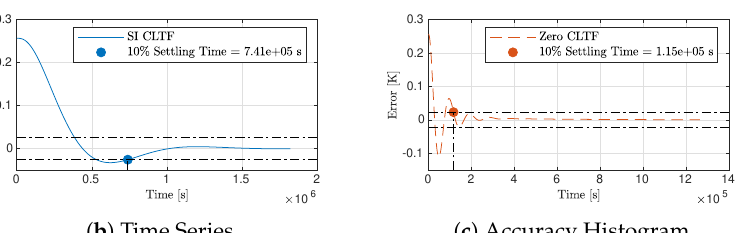
Figure 6. Comparisons of the simple integrator and zero controller via open loop transfer function bode diagram and closed loop mirror temperature response to an etalon fringe (0.257 K) step input to the error. The vertical lines in the Bode diagram indicate the two plant poles. Note the step responses are plotted on different time scales, since the settling times are separated by several orders of